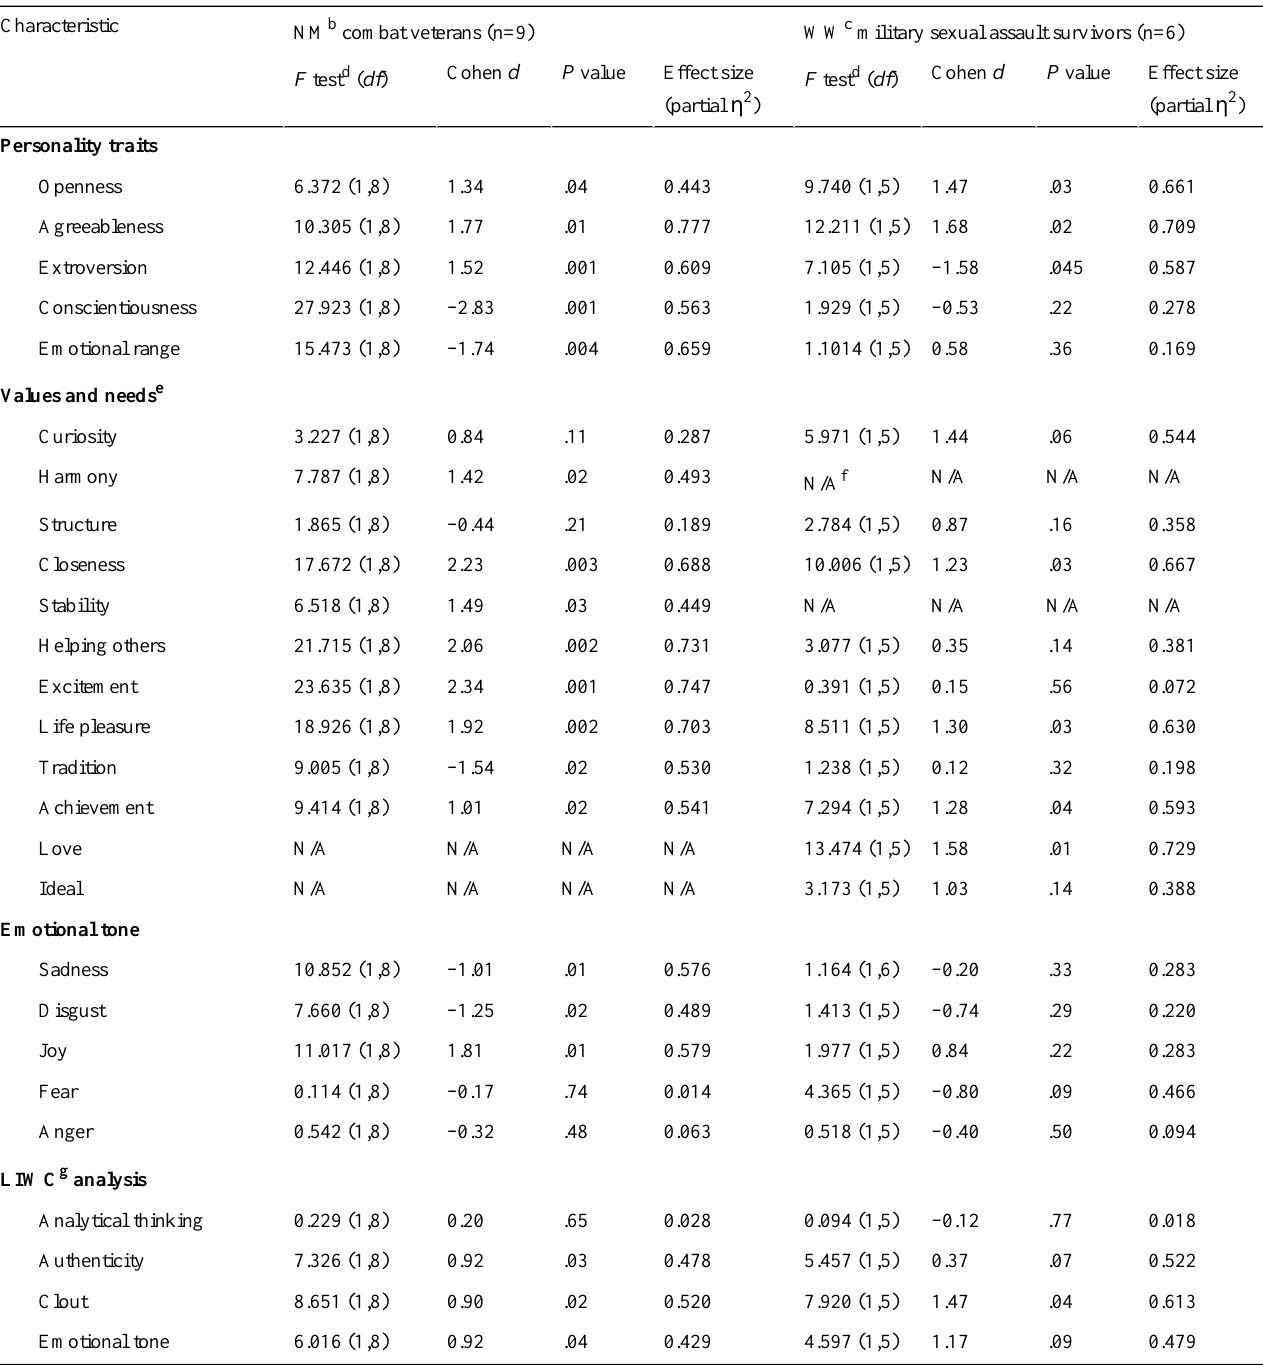
Table 2. Results of natural language analysis for personality traits, values, emotional tone, and Linguistic Inquiry and Word Count for treatment groups of Next Mission combat veterans and Women Warriors military sexual assault survivors.